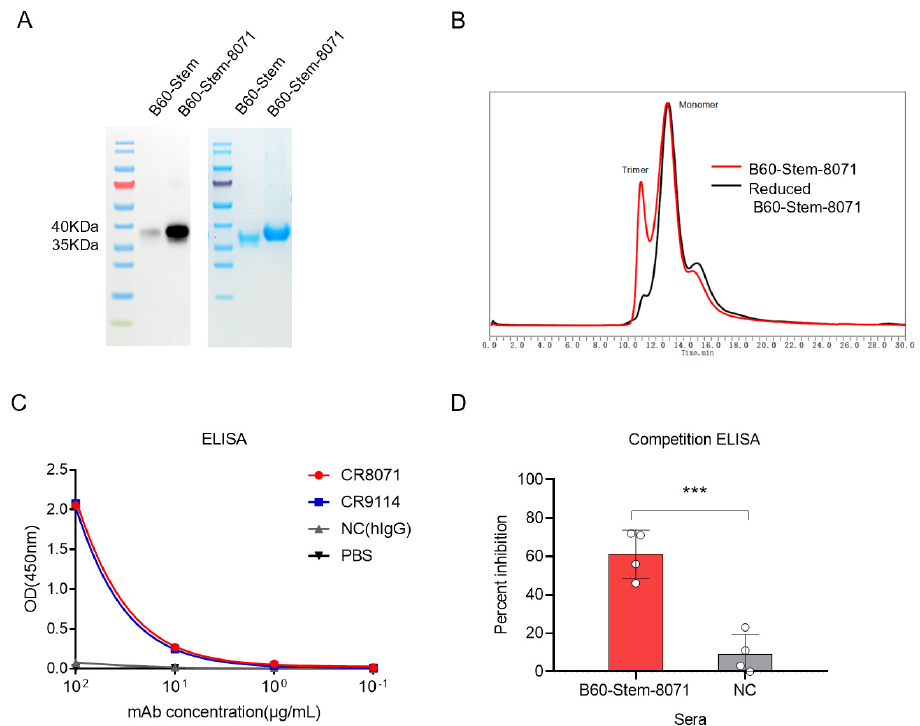
Figure 3. Characterization and conformational determination of B60-Stem-8071 HA. ( A ) The image of SDS-PAGE and the Western blot of purified B60-Stem-8071. ( B ) The HPLC analysis of B60-Stem-8071. B60-Stem-8071 under reducing condition (black) and non-reducing condition (red). ( C ) Binding curves of broadly neutralizing antibodies CR8071 (in red), CR9114 (in blue) and negative (NC) group (non-influenza antibody in grey). ELISA reactivity to purified B60-Stem-8071 ( D ) using a competition ELISA assay with two antisera (B60-stem-8071 and NC). CR8071 was used as a competitor, and NC group mice vaccinated with non-influenza protein. The data represented the average of four independent experiments and error bars indicated the standard errors of the means (SEM), with asterisks representing significant differences (*** p <